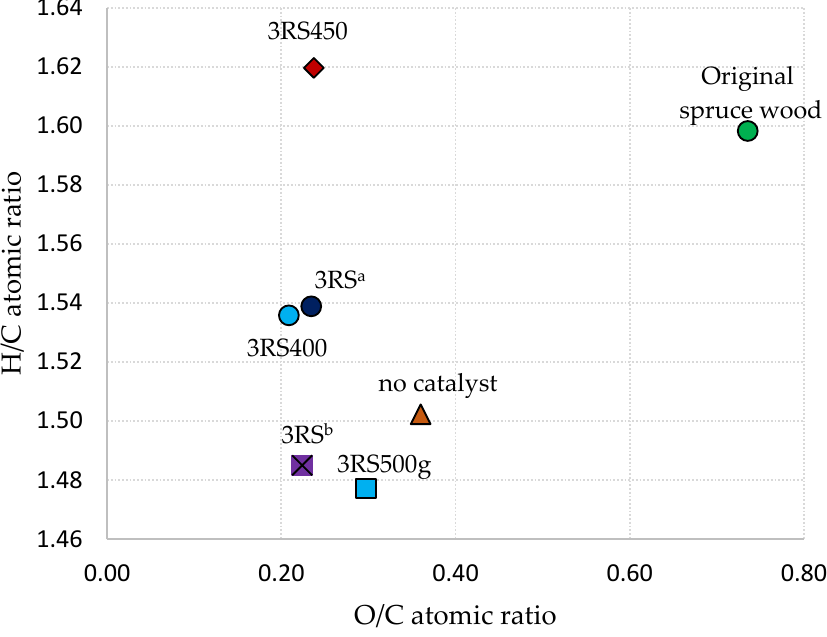
Figure 4. Van Krevelen diagram for the liquid products of spruce wood RCF at 225 ◦ C for 3 h over different catalyst ( a Original (non-oxidized) support; b the grain size is 1.0–1.6 mm). Carbon oxides (4.4 wt%) and trace methane (less than 0.1 wt%) were detected in